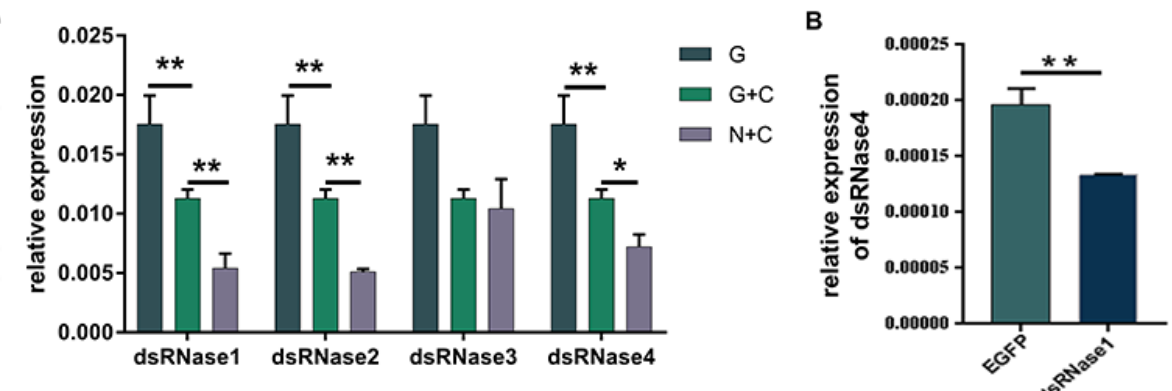
Figure 7. RNAi efficiency of PxCht after RNAi of PxdsRNase by oral dsRNA. ( A ) Expression level of PxCht in the fourth instar larvae 60 h after oral administration of 1200 ng of dsRNA of GFP , a mixture of dsGFP and dsPxCht (G + C) or a mixture of dsPxdsRNases and dsPxCht (N + C) was evaluated by RT-qPCR, and EF1 was used as the reference gene for normalization. Statistical analyses were performed using one-way ANOVA followed by the Turkey test. G, dsGFP; C, dsPxCht; N, dsPxdsRNase1/ dsPxdsRNase2/ dsPxdsRNase3/ dsPxdsRNase4. ( B ) PxdsRNase1 relative expression level in the fourth instar larvae 60 h after oral administration of dsPxdsRNase4. (*, p < 0.05; **, p < 0.01).